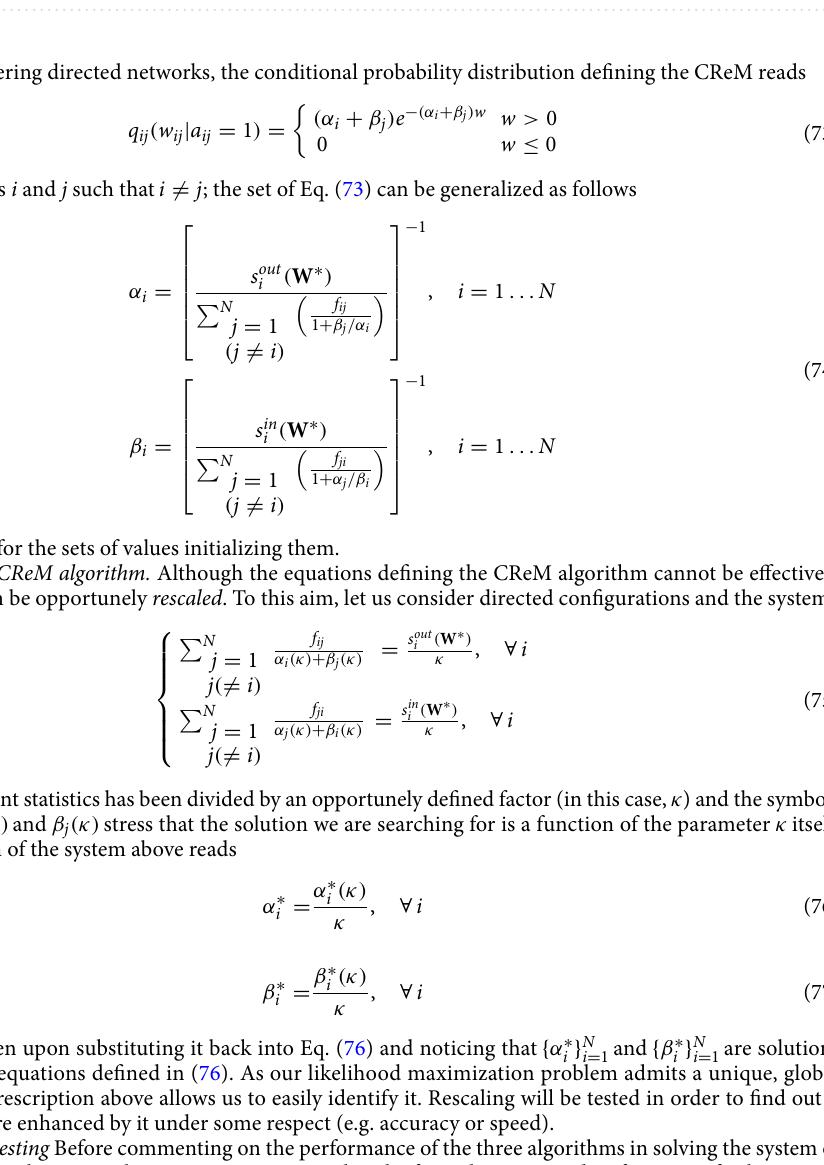
Table 6. Performance of Newton’s, quasi-Newton and the fixed-point algorithm to solve the system of equations defining the (undirected version of the) CReM, on a set of real-world WUNs. While Newton’s and the fixed-point method stop because the condition reaches the limit of 10,000 steps. The results on accuracy and speed indicate that Newton’s and the fixed-point method compete, outperforming the quasi-Newton one. Only the results corresponding to the best choice of initial conditions are